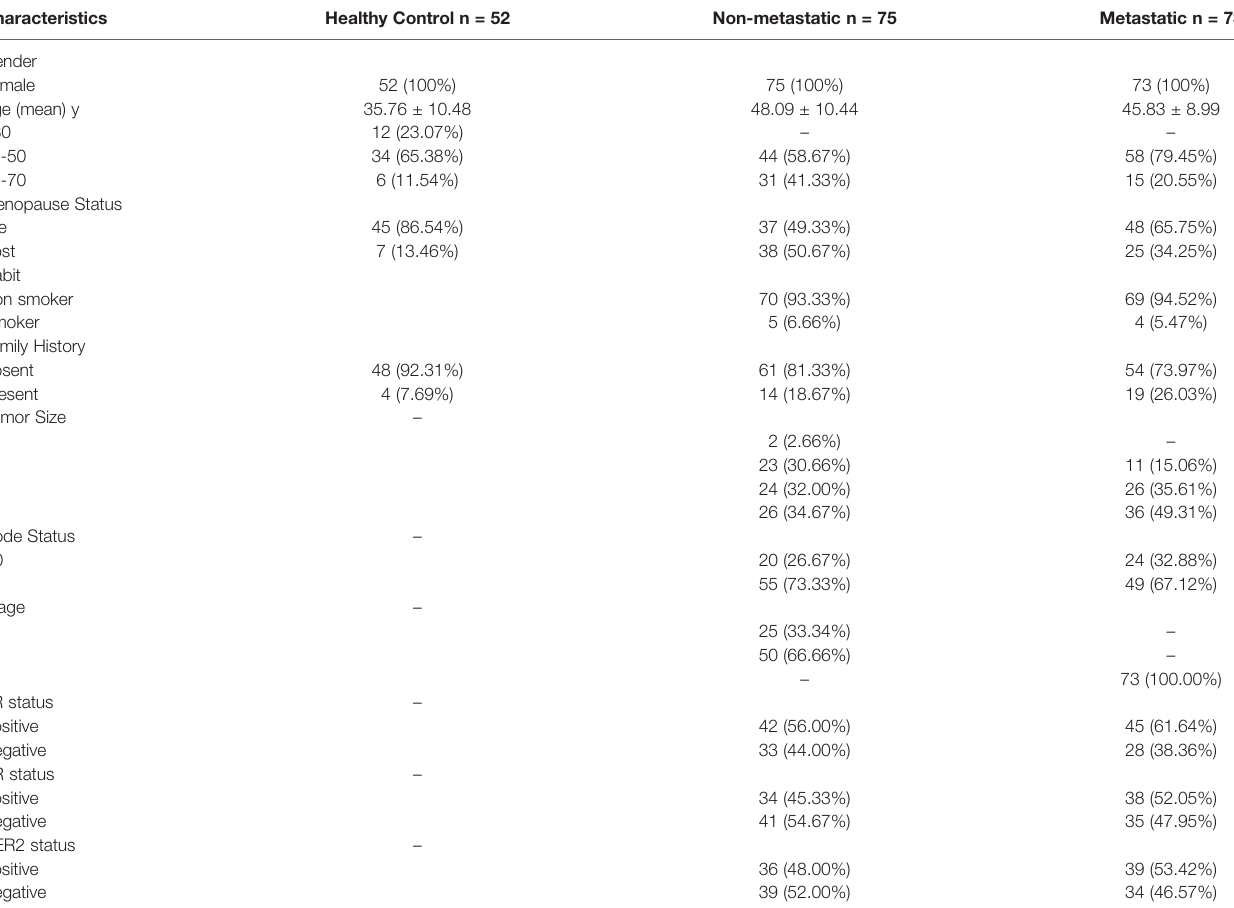
TABLE 1 | Demographic data of study